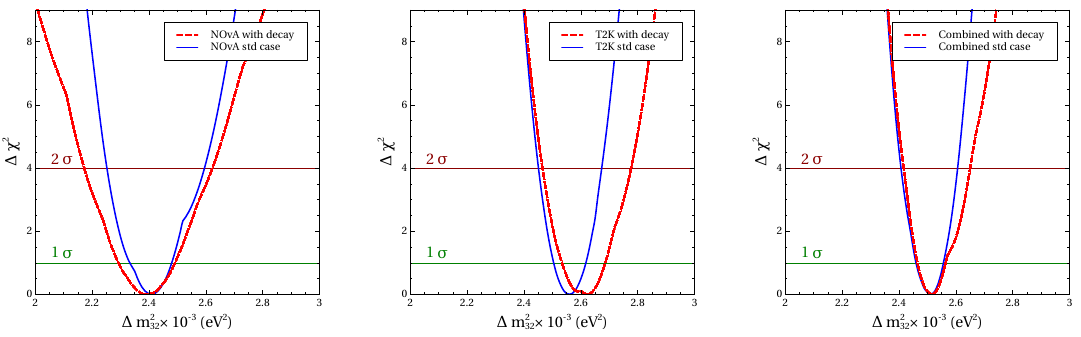
Figure 8 . (cid:1) (cid:31) 2 vs. (cid:1) m 2 , where the (cid:31) 2 is marginalised over all other 32